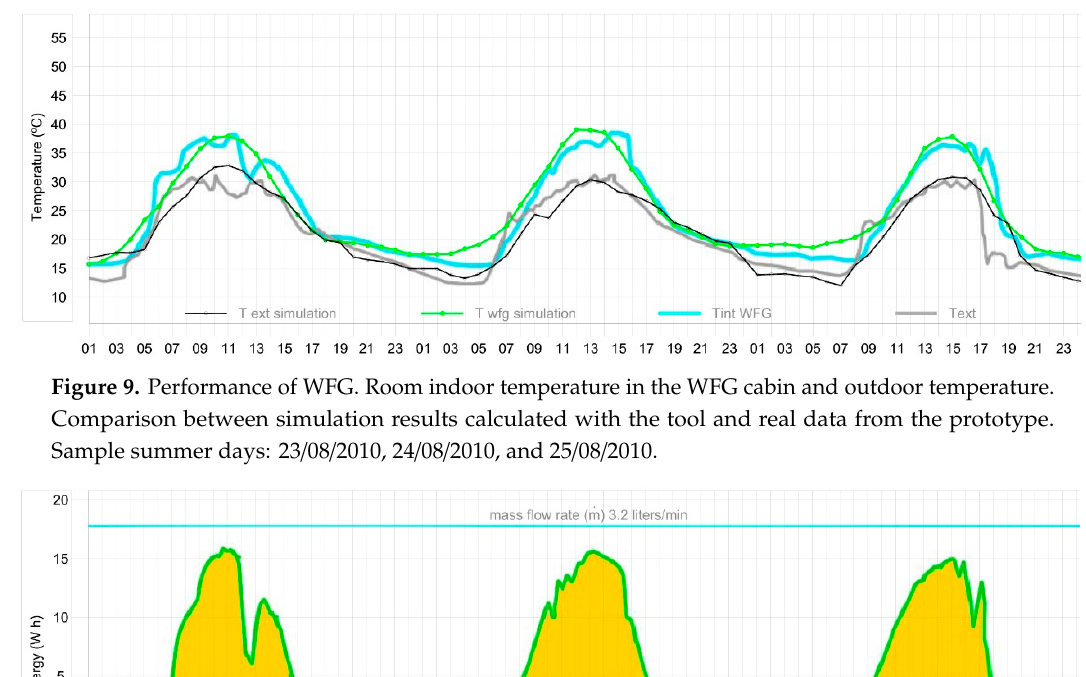
Figure 8. Comparison between measured data of the inlet and outlet temperature of the WFG cabin and results from simulation data. Sample summer days: 23/08/2010, 24/08/2010, and 25/08/2010.